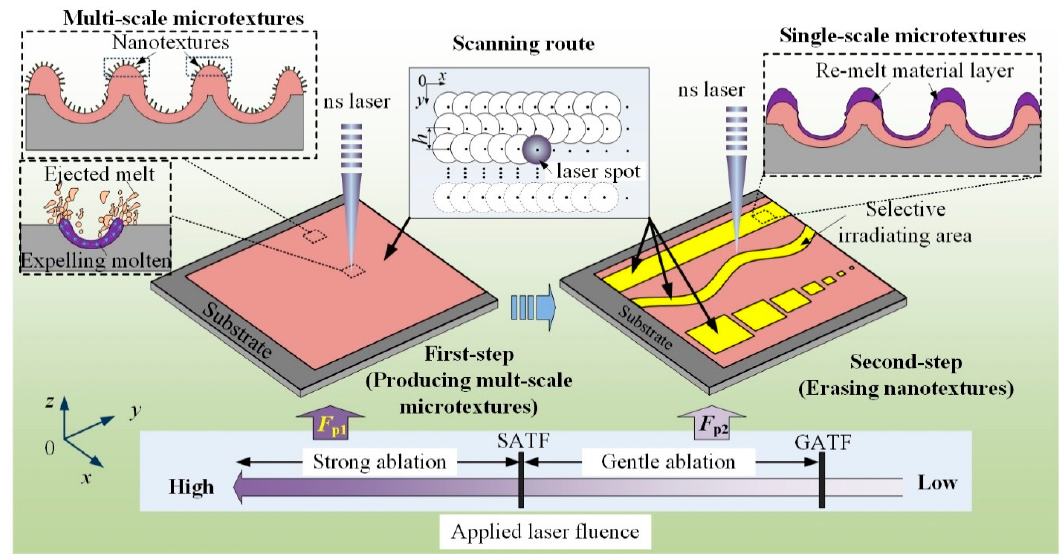
Figure 1. Principle of two-step laser-irradiation method to achieve micron-rough surface with single-scale microtextures.